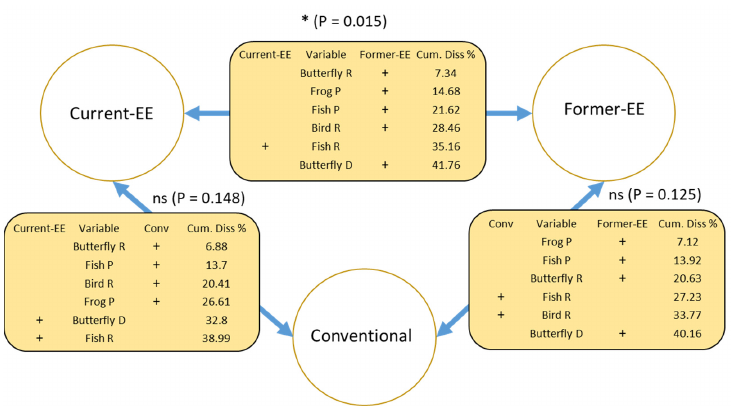
Figure 4. Differences between farmers’ appreciations of biodiversity based on rice management (in circles). Results of PERMANOVA pair-wise analyses are shown. SIMPER analyses (in orange boxes) show the variables (an animal and an observed ecosystem service: ‘R’ for regulating services, ‘P’ for provisioning services, ‘D’ for regulating disservices) contributing most to the dissimilarity between each pair of groups. The ‘+’ symbols indicate the group in which each variable is more prevalent. ‘Cum. Diss %’ = cumulative dissimilarity between pairs, expressed as a percentage. PERMANOVA results showed no significant differences in group-related percep- tions of trends in animal abundance and rice yields (Pseudo-F = 1.114, p = 0.363) or of the reasons underlying changing animal abundances (Pseudo-F = 1.915, p = 0.067). However, compared with the other groups, higher numbers of conventional farmers perceived in- creasing trends in both rice pests and yields (Figure S1). Farmers from all three categories shared a common perception about the two main reasons for declines in biodiversity, which they indicated as hunting and pesticide use (Figure S2).